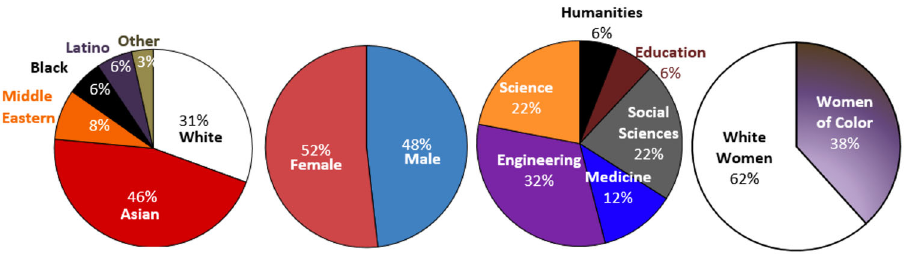
Fig. 1 Breakdown of student participants in the video simulation and faculty respondents to the survey of lived experiences included in the study. From left to right, student demographics ( n = 83), student gender, faculty fi eld ( n = 6), faculty race/ethnicity ( n = 50).